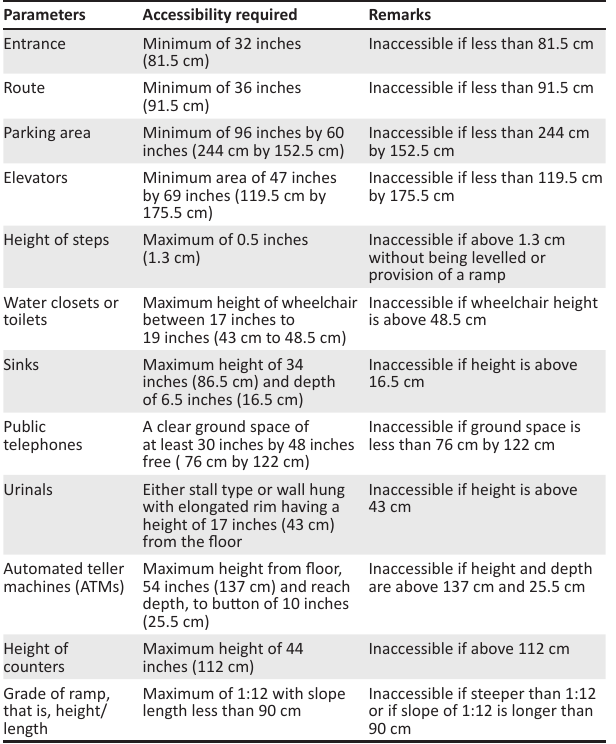
TABLE 1: Summary of required dimensions for wheelchair accessibility using an abridged form of the Americans with Disabilities Act Accessibility Guidelines. Parameters